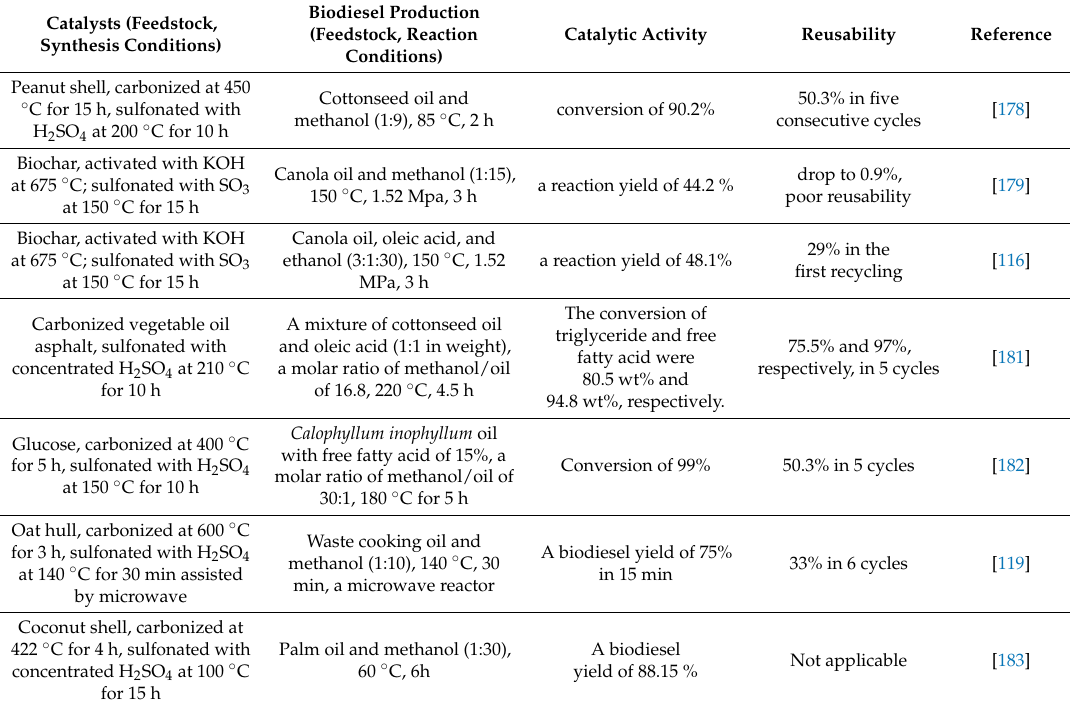
Table 2. Biochar-based solid-acid catalysts for biodiesel